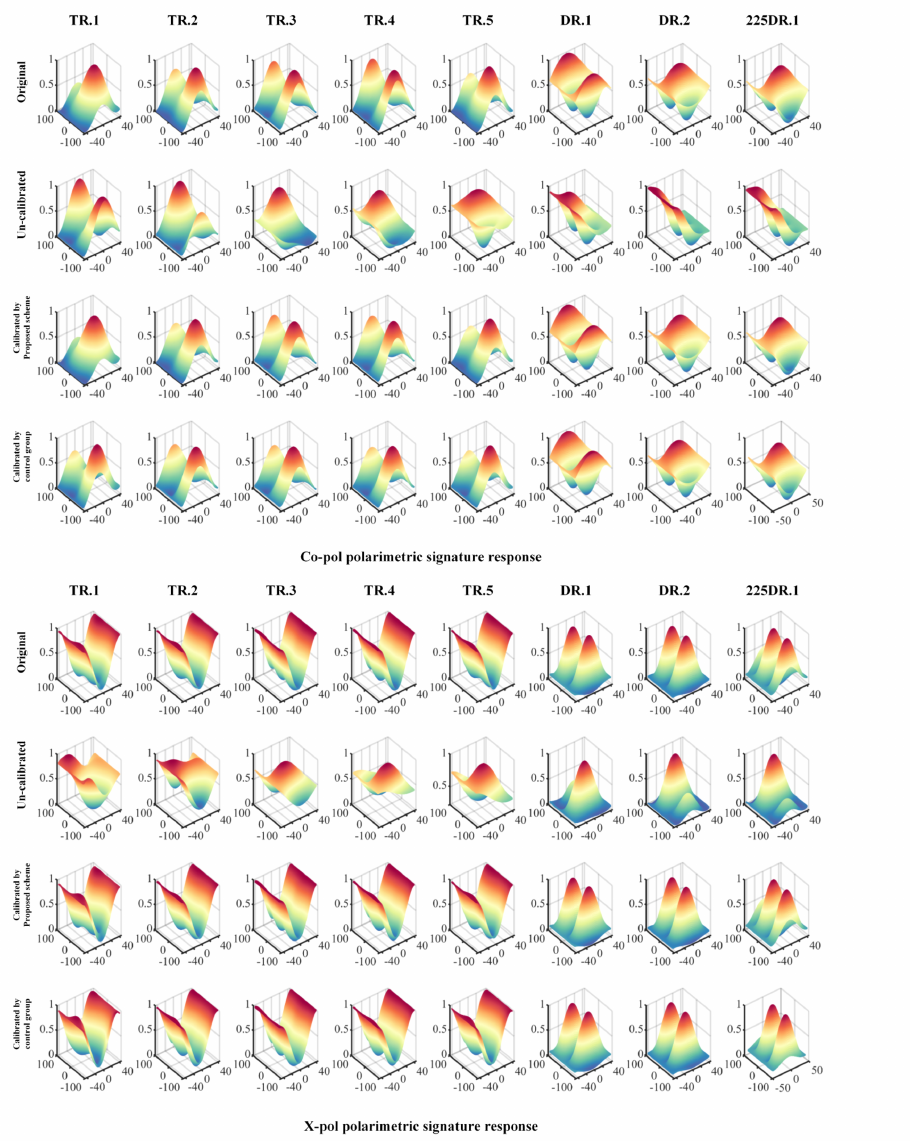
Figure 8. Polarimetric (co-pol and x-pol) signature responses of the strong point targets in the CQP SAR data set, without additive noise in linear polarimetric